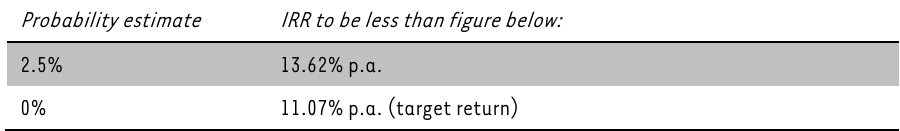
Probabilities of downside IRR of the investments in Set B Probability estimate IRR to be less than figure